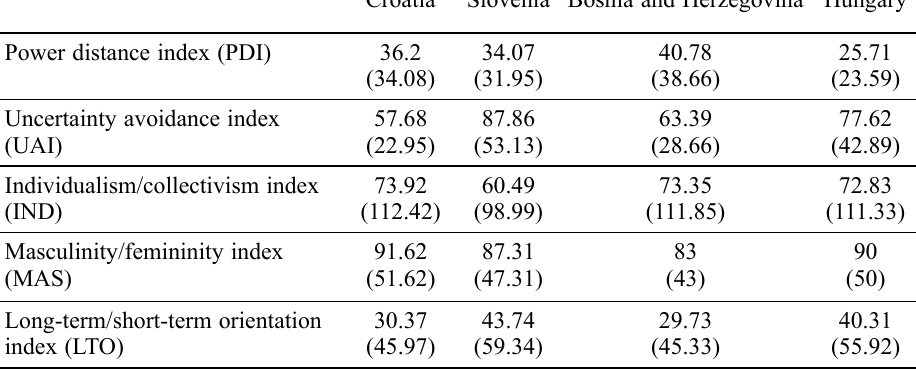
Table 6. Calibrated (uncalibrated) positions of the countries on five Hofstede’s dimensions